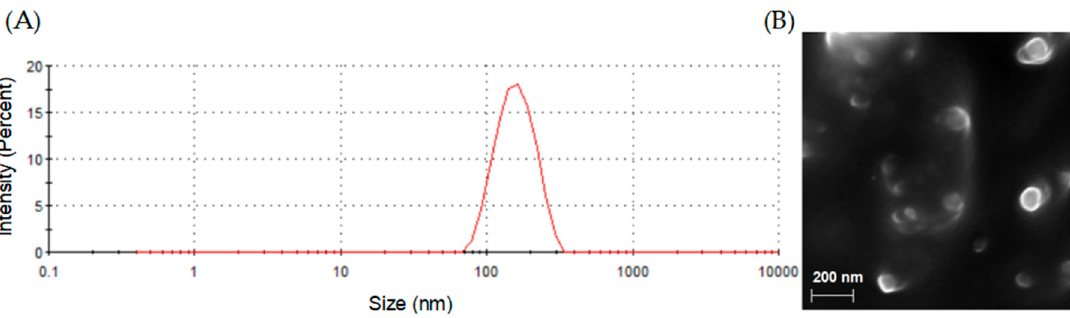
Figure 1. ( A ) Size distribution image of liposomes containing both phenethyl isothiocyanate (PEITC) and cisplatin (CDDP) (Lipo-PEITC-CDDP) and ( B ) SEM image of Lipo-PEITC-CDDP.